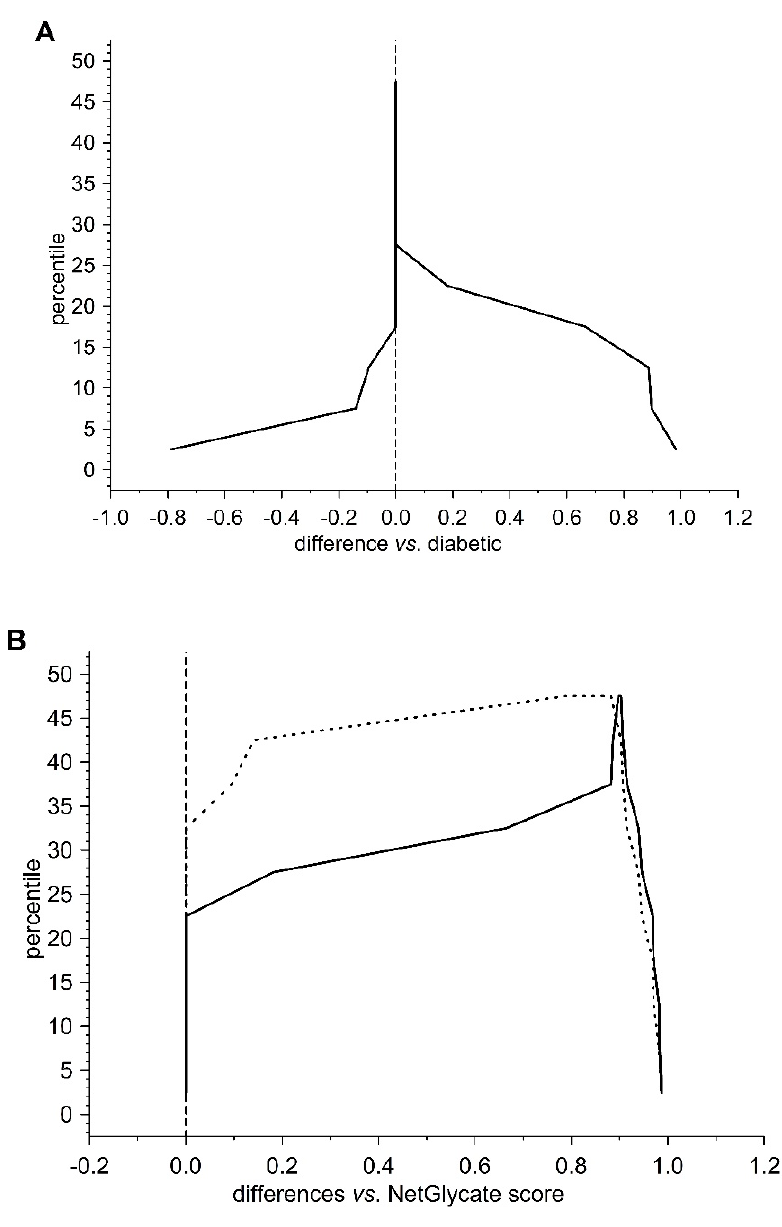
Figure 5. Mountain plots comparing the NetGlycate scores of glycation sites in control subjects and T2DM patients with theoretical estimates for glycation positions of high or low glycation potential in beta chain of fibrinogen. The plot was created by evaluating the percentiles for ascending differences between the normalized scores: ( A ) differences of the NetGlycate-estimated scores (normalized to the scale from 0 to 1) between diabetic patients and control subjects ( norm score diabetic − norm score control ), ( B ) differences of the NetGlycate-estimated scores (normalized to the scale from 0 to 1) between theoretical estimates for high or low glycation potential sites and the actual glycation sites revealed in diabetic patients (solid line) and control subjects (dashed line) ( norm score theoretical – norm score control ; norm score theoretical – norm score diabetic ).